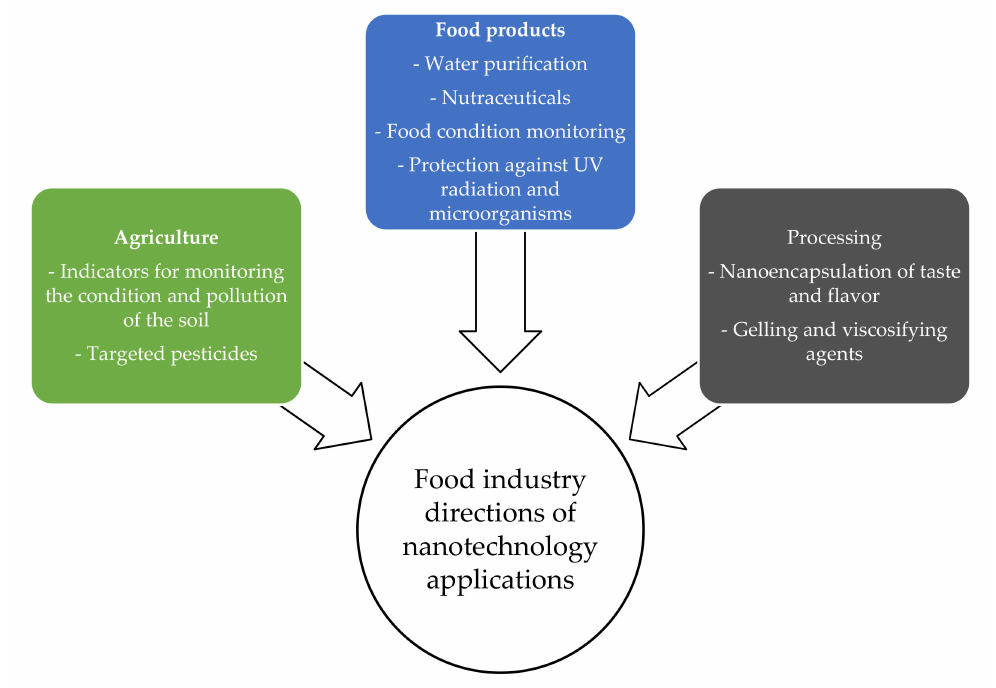
Figure 3. Directions of nanotechnology applications in the food industry based on